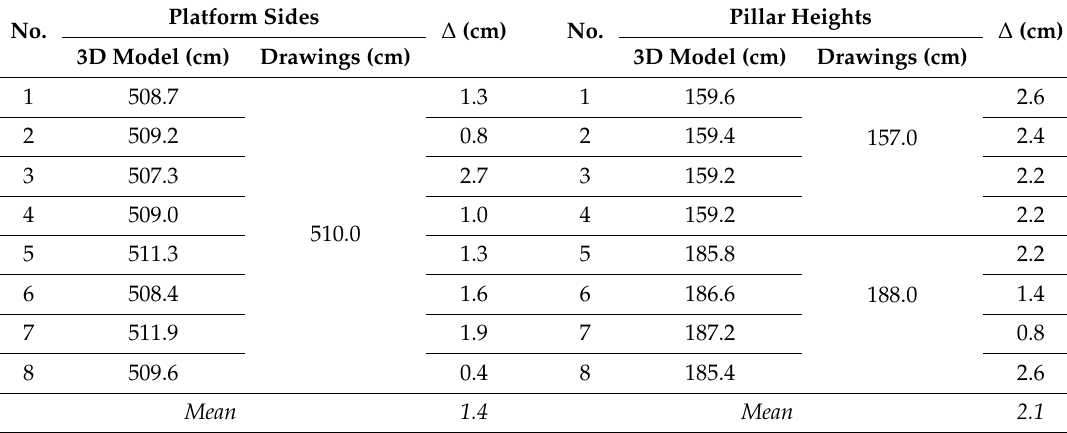
Table 2. Comparison of some dimensions of the Central Pavilion of Siti Inggil between the resulting 3D model and the architectural drawings. Shown here are comparisons for the pavilion’s platforms’ sides and pillar